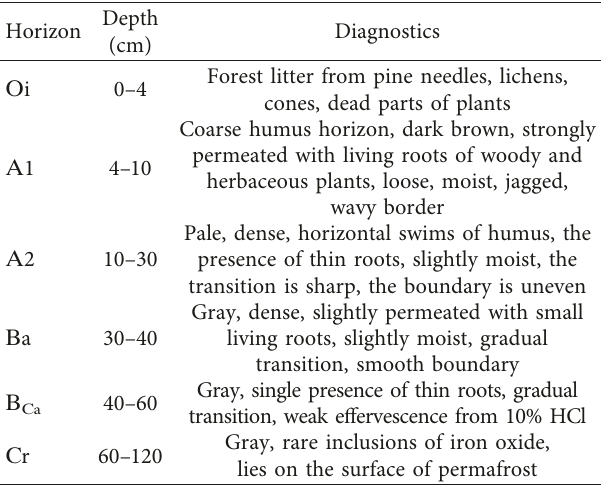
Table 1: Morphological description of Cryosols Haplic Cambisols Dystric soil section on the ice